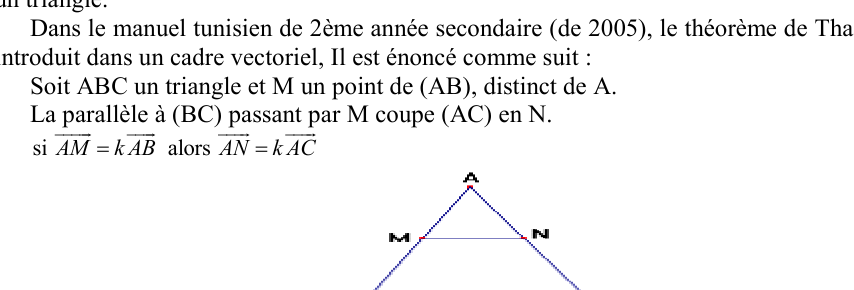
Fig. 4. Figure « parallèles et sécantes » et Figure « triangle étendu ».